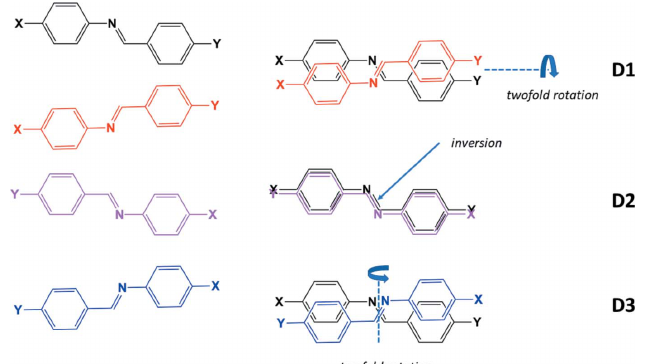
Figure 1 Disorder types in